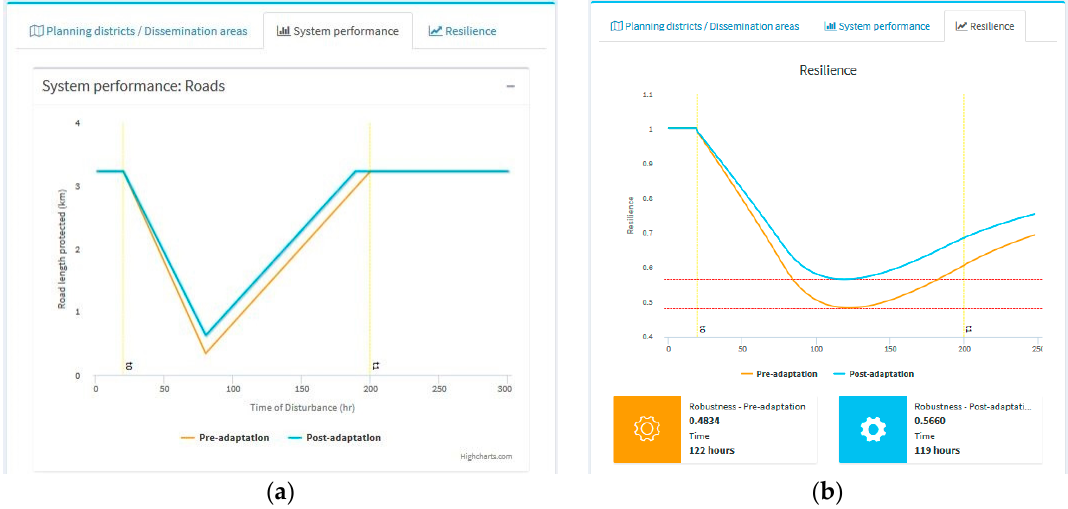
Figure 15. System performance graphs for each sector; ( a ) interactive resilience graph (green line); and ( b ) resilience combining real time and pro ‐ active adaptation measures (orange line).